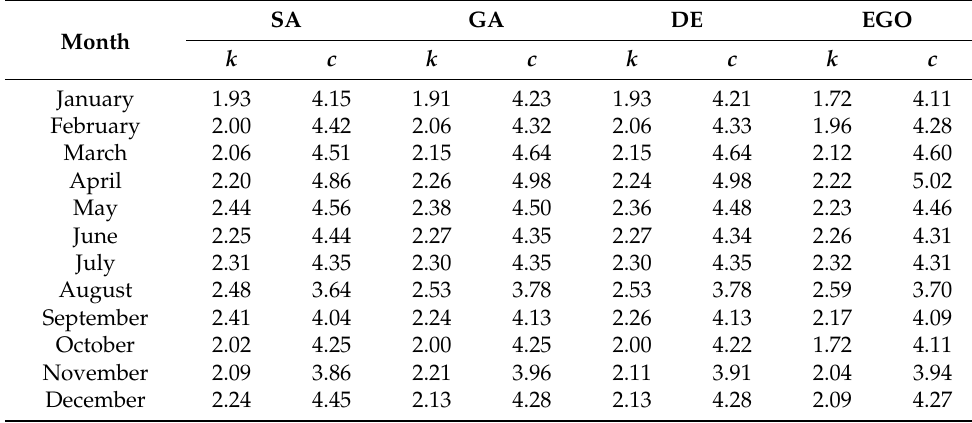
Table 4. Estimated TPWD parameters for monthly wind speed data.